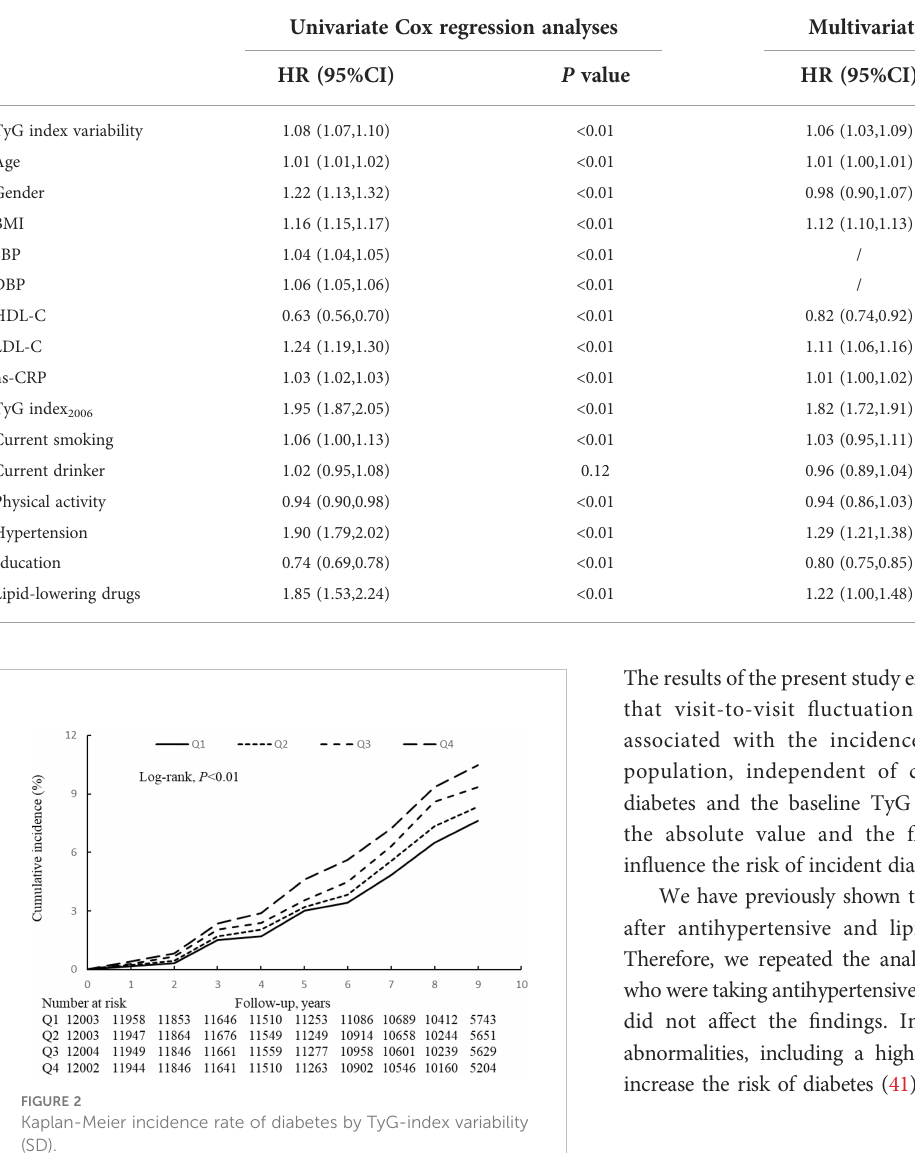
TABLE 2 Risk factors for diabetes were analyzed by univariate and multivariate Cox regression analysis.